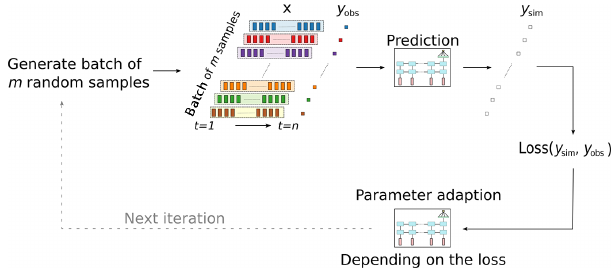
Figure 3. Illustration of one iteration step in the training process of the LSTM. A random batch of input data x consisting of m inde- pendent training samples (depicted by the colours) is used in each step. Each training sample consists of n days of look-back data and one target value ( y obs ) to predict. The loss is computed from the observed discharge and the network’s predictions y sim and is used to update the network